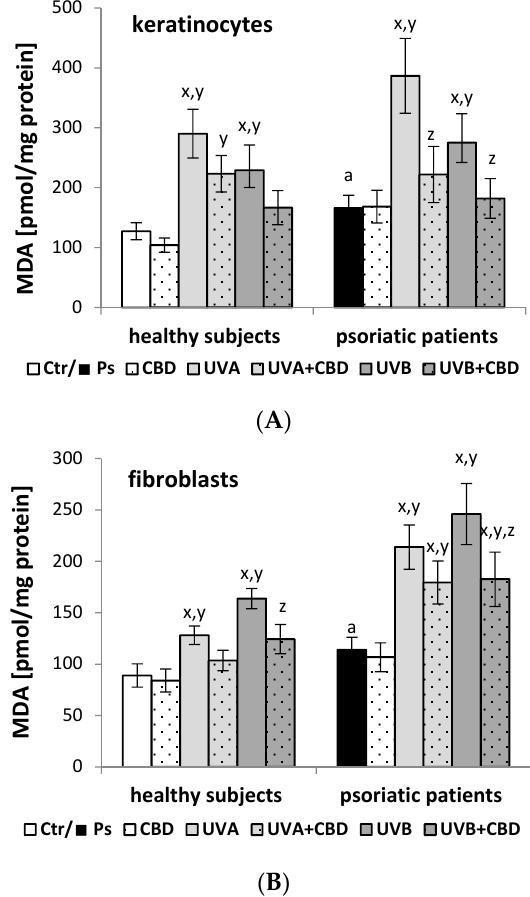
Figure 3. The level of lipid peroxidation product [malondialdehyde (MDA)] in keratinocytes ( A ) and fibroblasts ( B ) isolated from skin of healthy subjects (Ctr) ( n = 6) and psoriatic patients (Ps) ( n = 6) exposed to UVA (30 J/cm 2 ) and UVB (60 mJ/cm 2 ) radiation as well as untreated and treated with CBD (4 μ M). The mean values ± SD and statistically significant differences for p < 0.05 are pre- sented; a —differences between Ps and Ctr groups; x —differences vs. Ctr or Ps group; y —differences